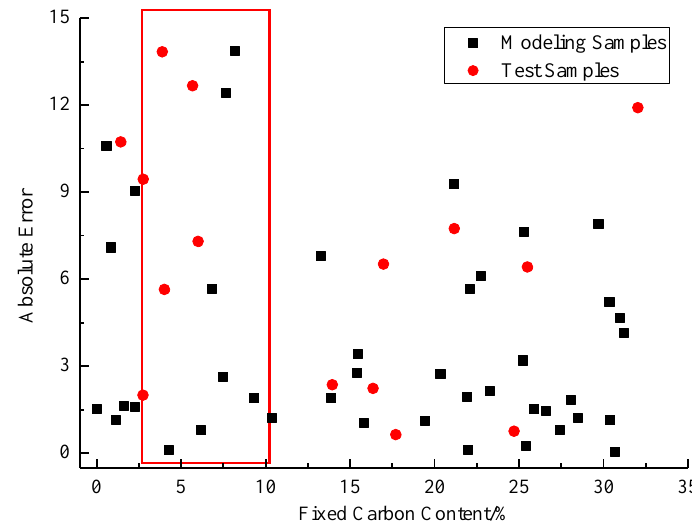
Figure 9. Absolute error diagram of the modeled samples and test samples.